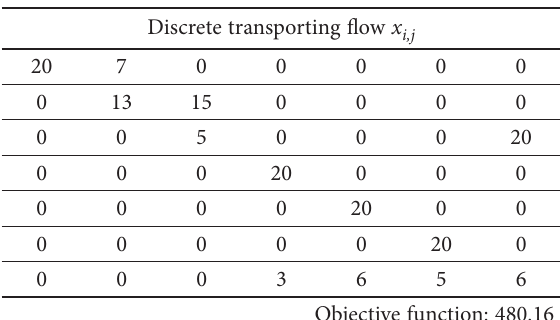
Table 10. Best obtained discrete solution for the 7×7 test problem with cost function D Discrete transporting flow x i,j